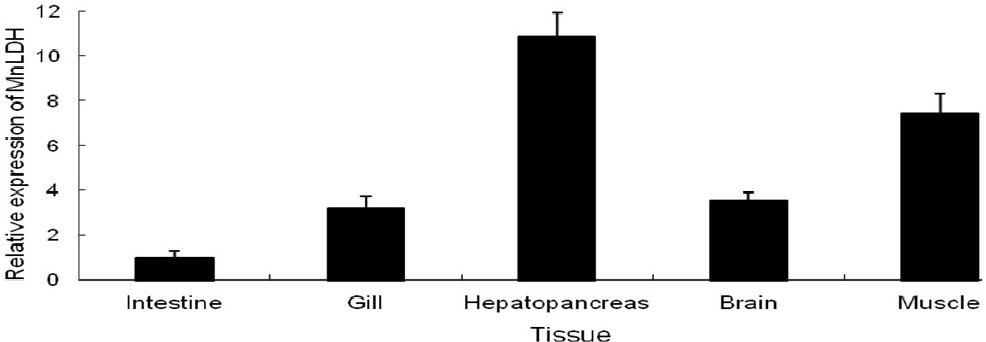
Figure 4. Quantitative real-time PCR analysis of LDH mRNA expression in various tissues of M. nipponense . The ratio compares the gene expression in different tissues to that in heart. The β-actin gene was used as an internal control. Vertical bars represent mean ± standard error of the mean (SEM) values for triplicate samples.